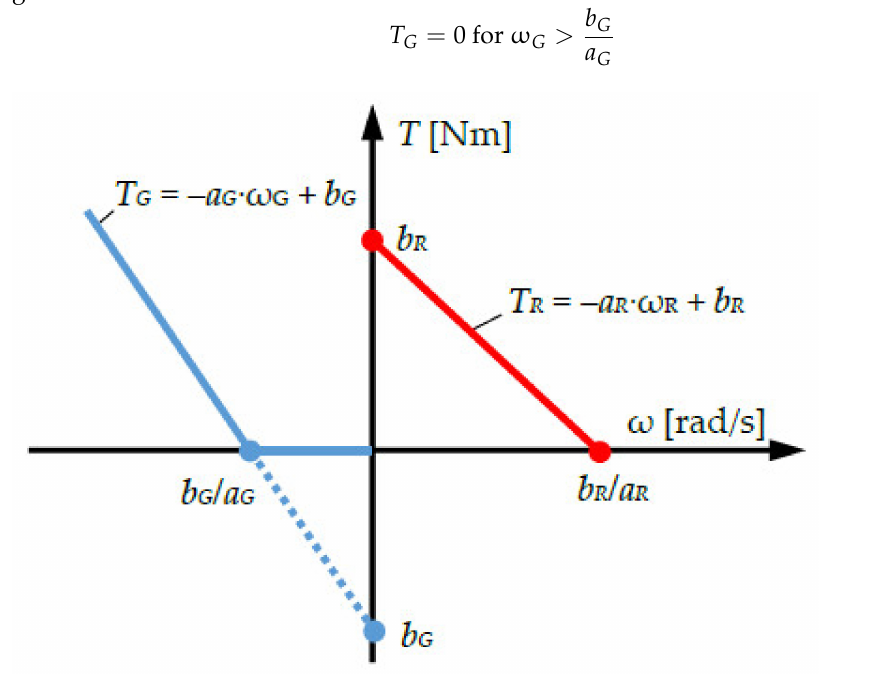
Figure 4. Linear mechanical characteristics of a wind rotor ( R ) and a DC generator ( G